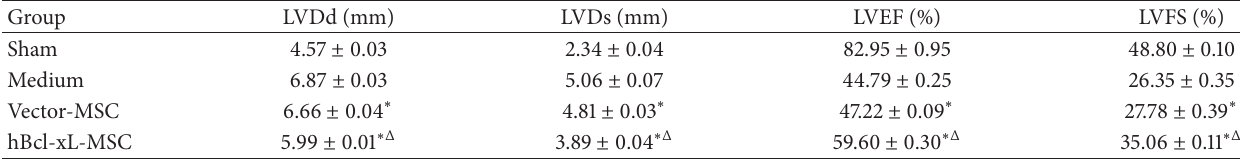
Table 1: Echocardiography at 4 weeks after MSC